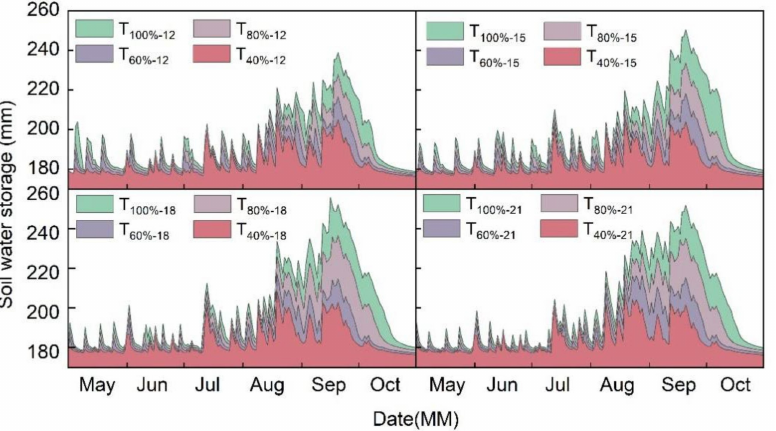
Figure 9. Simulation and comparison of soil water storage (SWS) under different irrigation conditions.